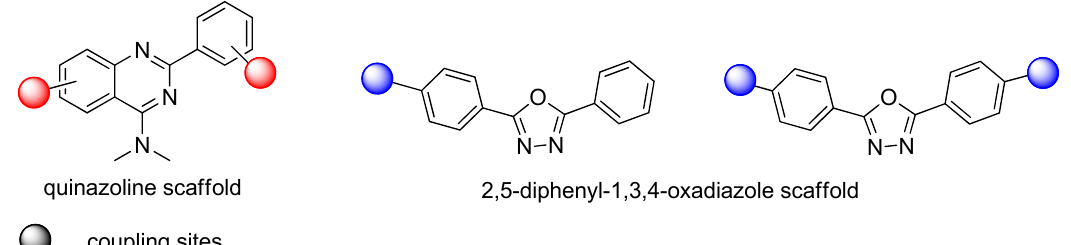
Figure 1. Building scaffolds of the synthesized arrangements with the indicated coupling sites.